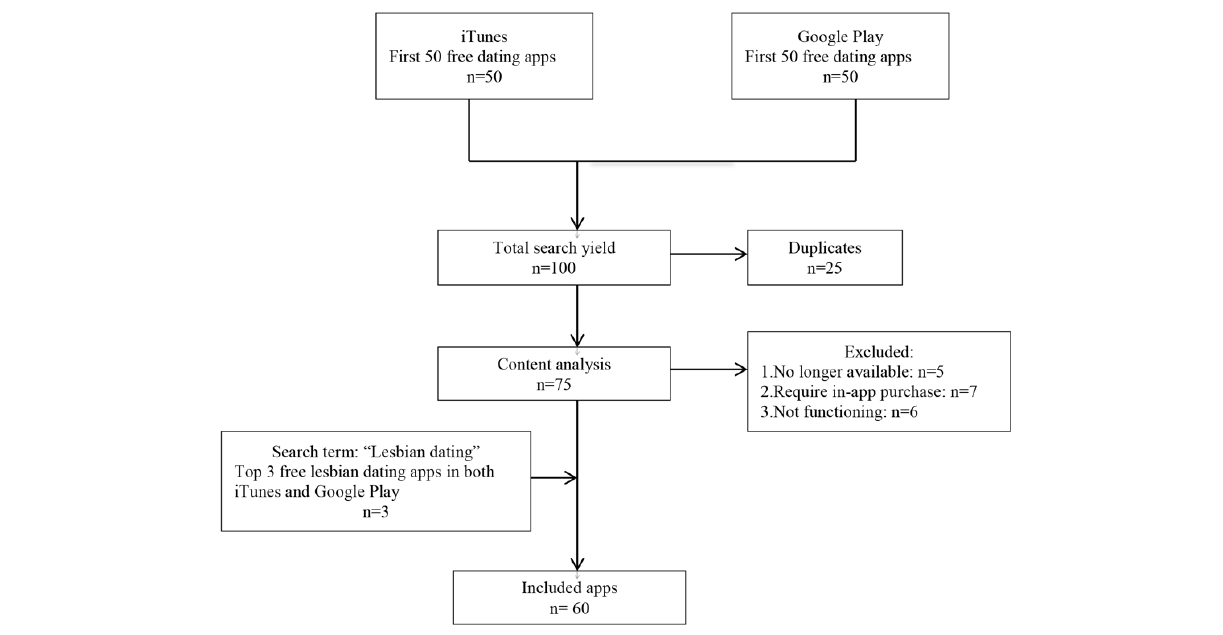
Figure 2. Inclusion of dating